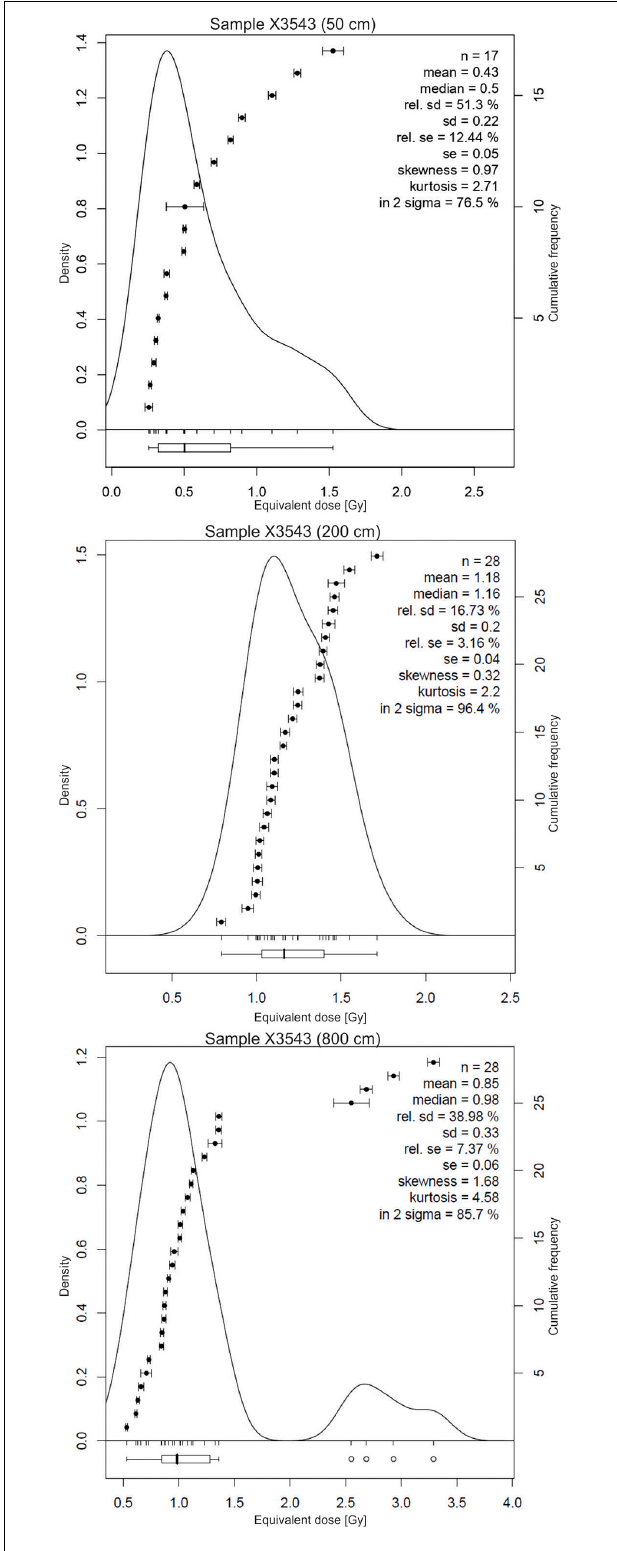
FIGURE 3 | Kernel density plots featuring the distribution of individual paleodose values and associated statistical summary for each sample.